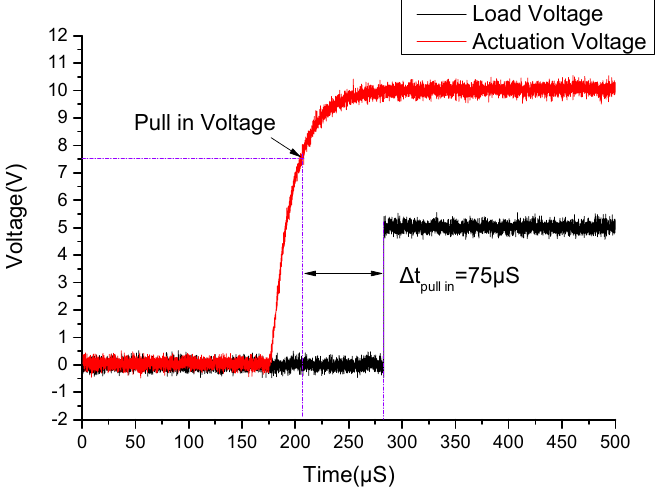
Figure 11. The measured switching-on time of the proposed MEMS relay.